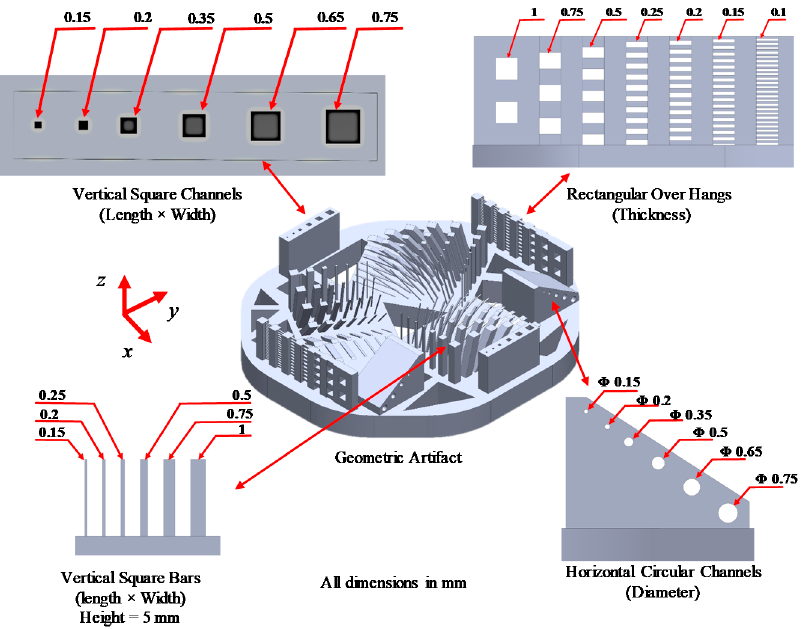
Figure 7. Geometric artifact to determine the minimum feasible feature size manufactured.